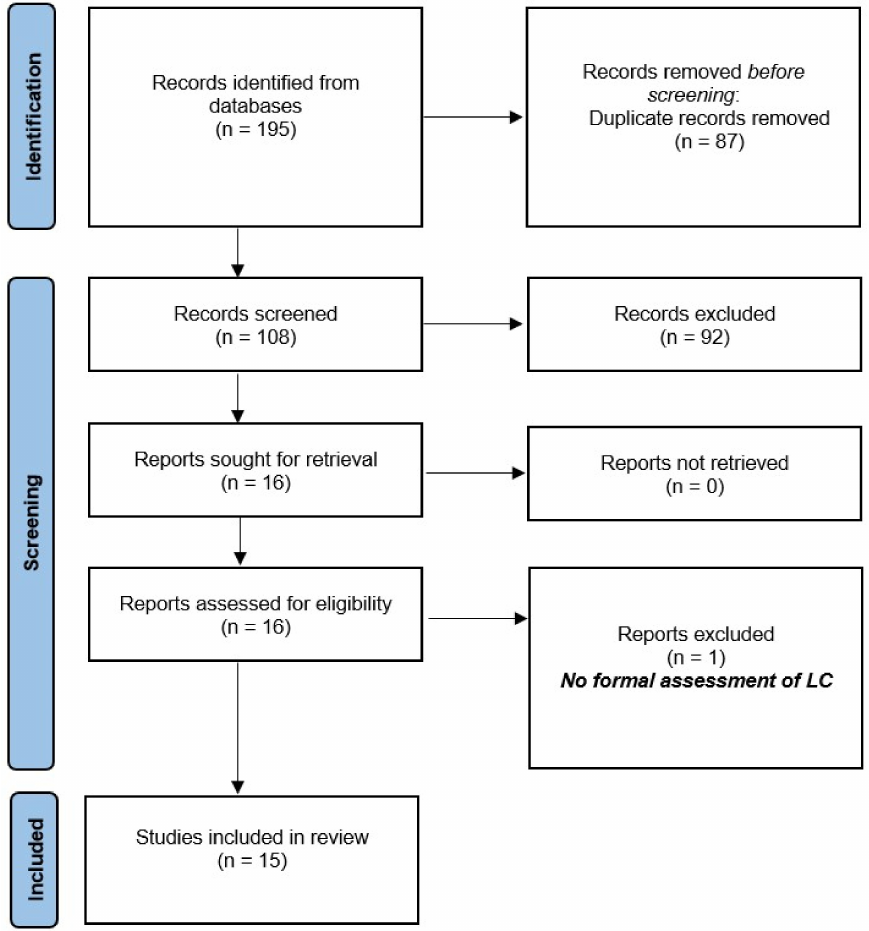
Figure 1. Selection of the studies using the PRISMA flow diagram. LC: learning